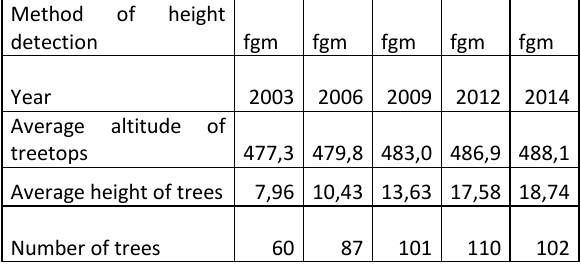
Table 3. Changes in tree heights